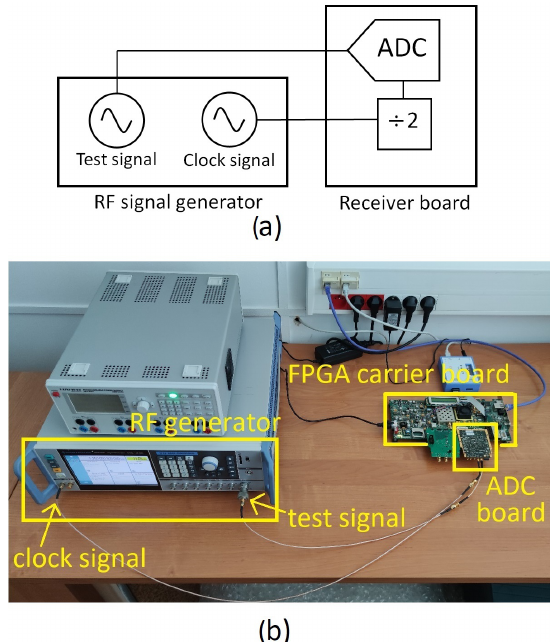
Figure 6. ( a ) Block diagram and ( b ) photo of the measurement set-up used for the metrological characterization of the ADC-based